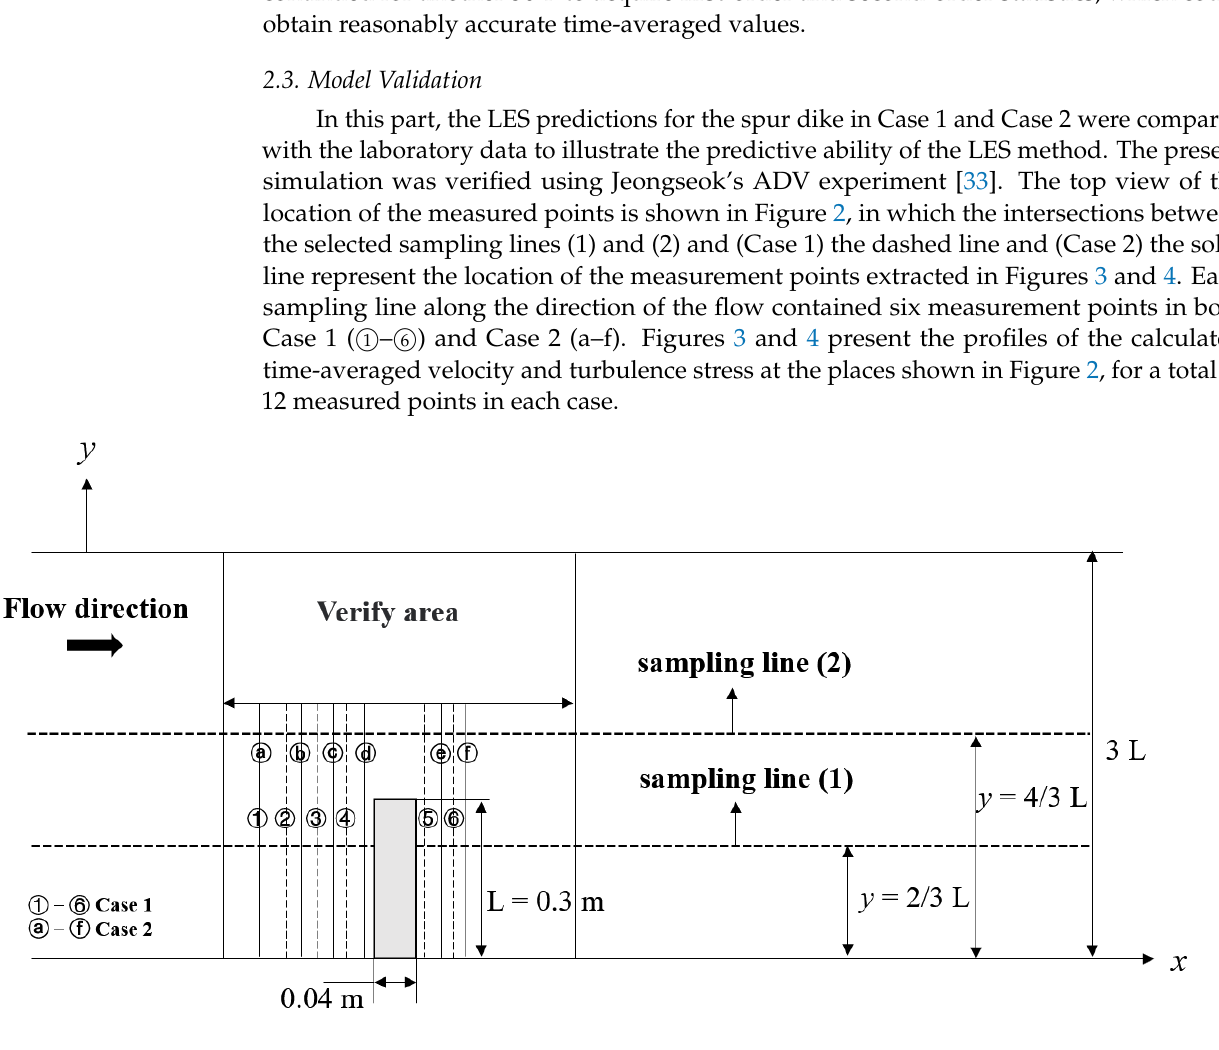
Figure 2. Top view of the location of the sampling lines in Case 1 and Case 2. The intersections of the horizontal sampling lines (1) and (2) with vertical dashed (for Case 1) and solid (for Case 2) lines indicate the experimental measurement points.